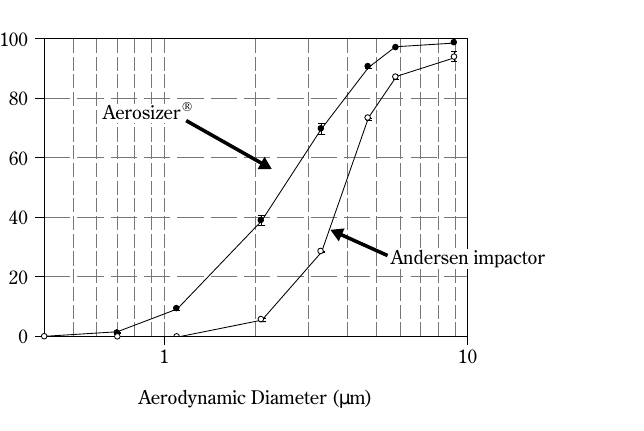
Undersizing of budesonide-based pMDI formulation by Aerosizer ® TOF analyzer compared with Andersen 8-Stage impactor, caused by lack of discrimination between particles of API and surfactant (from [119] ordinate scale: cumulative mass % (cid:7) stated size used by permission, Mary Ann Liebert